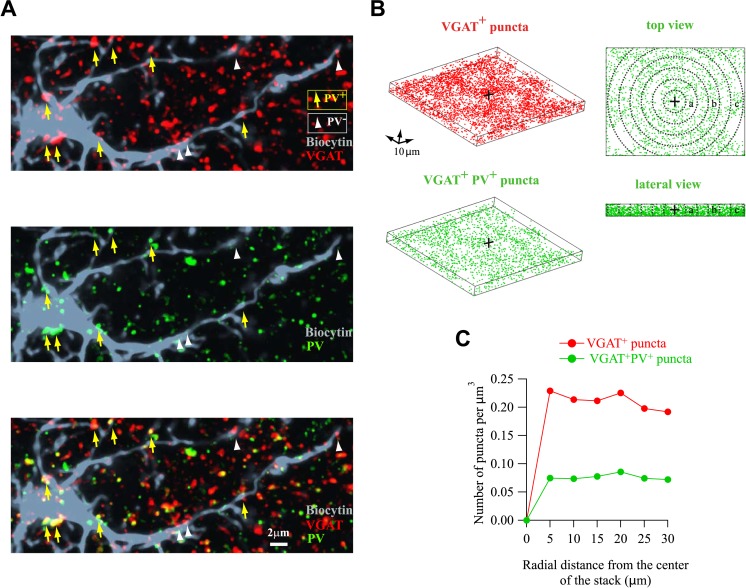
Homogeneous distribution of VGAT+/PV+ puncta around NG2 cells.(A) Original immunostainings against VGAT (red) and PV (green) around the biocytin-labeled NG2 cell (gray) shown in Figure 2C. Note the accurate match of colocalized puncta between these images and 3D reconstructions in Figure 2C. (B) Distribution of all VGAT+ (red) and VGAT+/PV+ (green) puncta around a biocytin-labeled NG2 cell (left). Top and lateral views illustrate how the density of puncta was calculated in defined volumes from the center of the field (right, dashed lines; see ‘Materials and methods’). (C) Distribution of the density of all VGAT+ (red) and VGAT+/PV+ (green) puncta for each volume in respect to the center of the field. Note the homogeneous distribution of both all VGAT+ and VGAT+/PV+ puncta, confirming that FSI inputs are not unequally located around the soma of the NG2 cell.